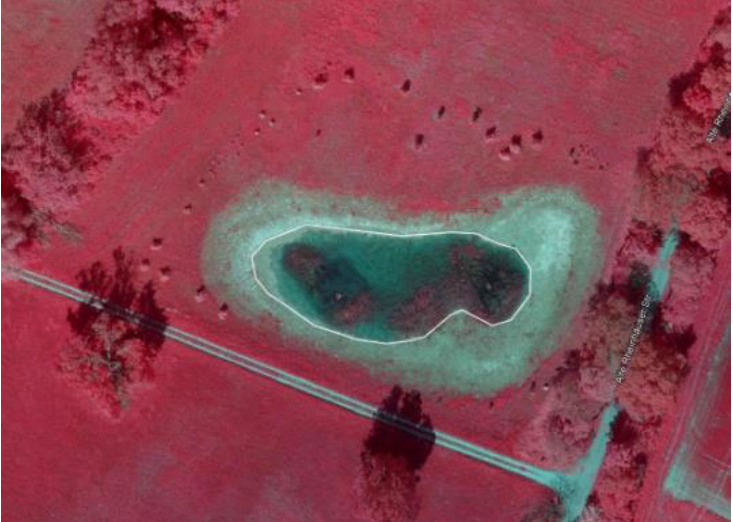
Figure 3. Area detected by actual data and water level shows a typical breeding area automatically detected by cluster analytics